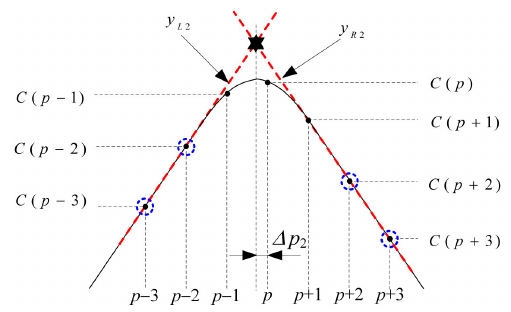
Figure 6. Estimation of ∆ p 2 using C ( p ± 2 ) and C ( p ± 3 ) .